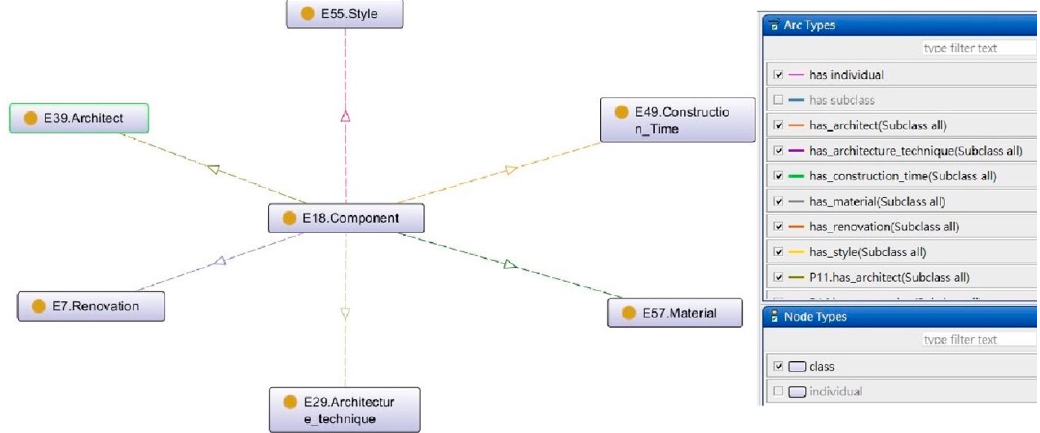
Figure 9. The connection of HBIM elements and ontological knowledge based on Revit Dynamo, where the corresponding knowledge of the element selected in Revit can be displayed in the “ watch ” window. 4. Results and Discussion 4.1. Parametric/Semantic HBIM Models HBIM is a detailed semantic model composed of the defined “classes” and entities. In this project, three geometric models are obtained, including the holistic surface mesh model, parametric HBIM model from point clouds, and semantic HBIM model from the mesh. Compared to the holistic surface mesh, the HBIM are semantic volume models with attached properties (Table 1). Two types of BIM “classes” and HBIM models are obtained: (i) The parametric “classes” and entities consisting of a set of geometric rules and properties generate the parametric HBIM from the point clouds, while (ii) the non-changeable “classes” and entities with fixed shape generate the semantic HBIM from the surface mesh. Table 1. Comparison among different heritage models. Aspects